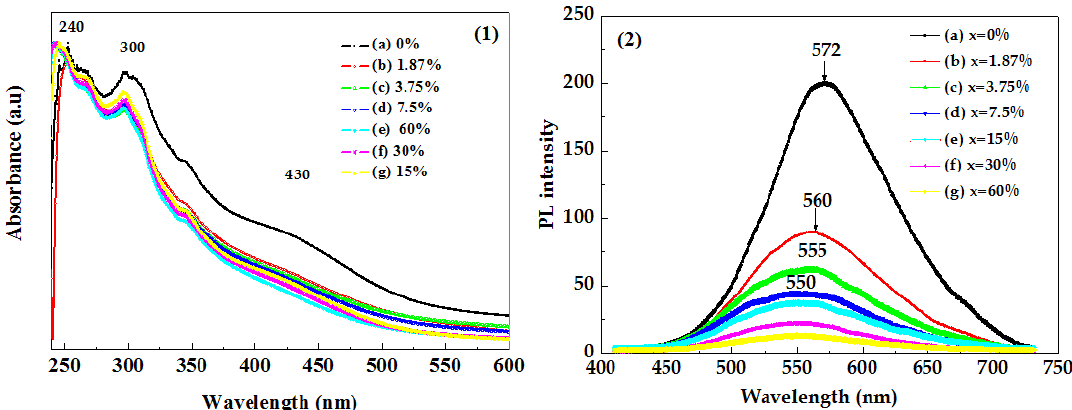
Figure 10. ( 1 ) OA and ( 2 ) PL spectra in chloroform solvent of pristine PVK-HeT ( a ) and those of PVK-HeT/SWCNT composites at various SWCNT weight concentrations: ( b ) 1.87%, ( c ) 3.75%, ( d ) 7.5%, ( e ) 15%, ( f ) 30%, and ( g ) 60%.